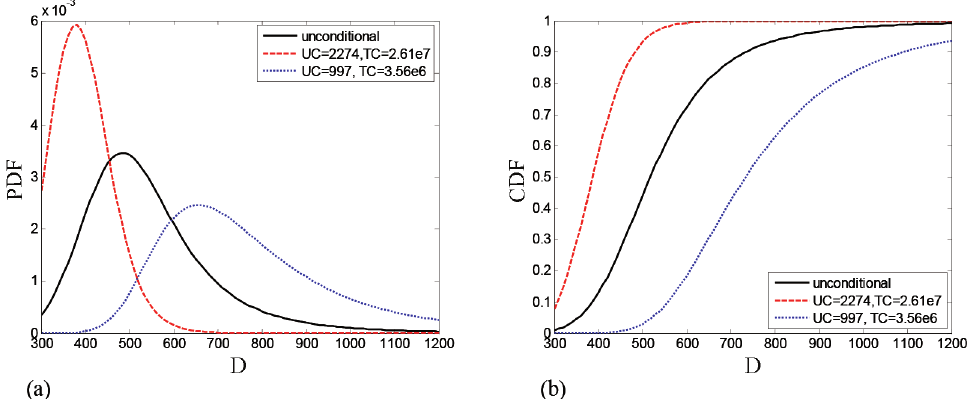
Figure 8. Conditional distribution of D given UC and TC